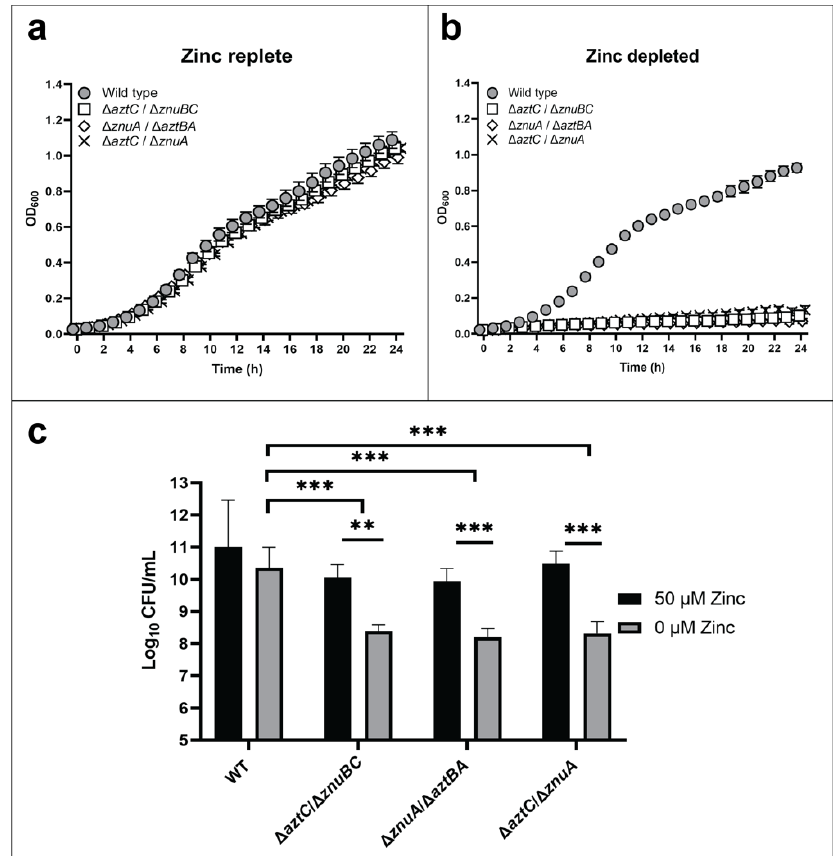
Figure 2. The ZnuABC and AztABCD transporter systems do not crosstalk. Growth curves at 600 nm in zinc-replete ( a ) or zinc-depleted ( b ) conditions for 24 h. Cellular viability quantification after 48 h of incubation ( c ). Error bars represent the mean ± S.D. of triplicate experiments. For the CFU, two-way ANOVA was used followed by Tukey’s multiple comparison test to show that viability was significantly decreased in mutant strains under zinc limited conditions, *** p < 0.001, ** p < 0.01.